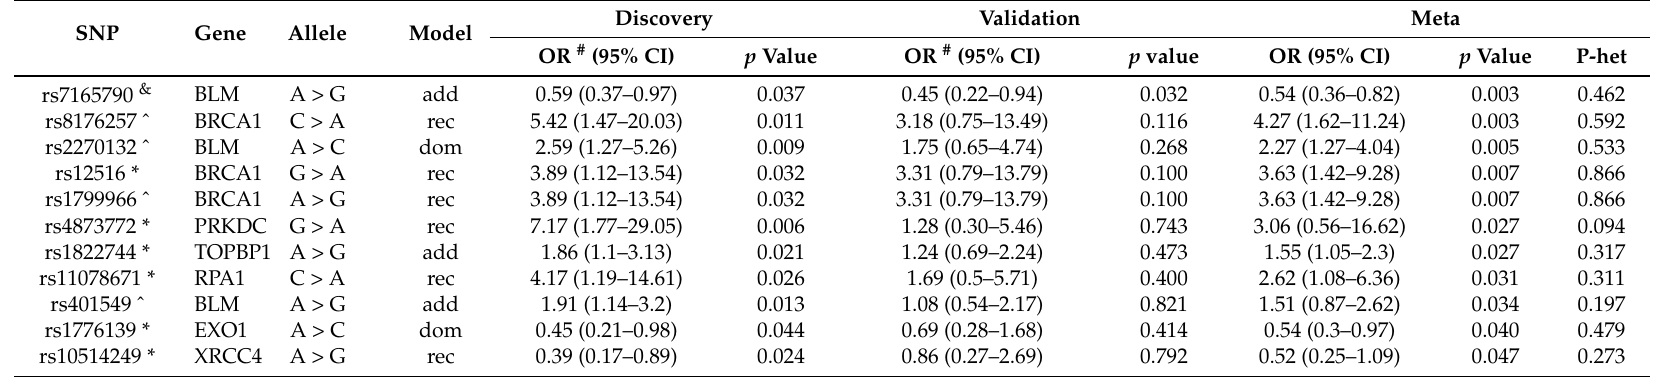
Table 2. Selected SNPs associated with radiation esophagitis.